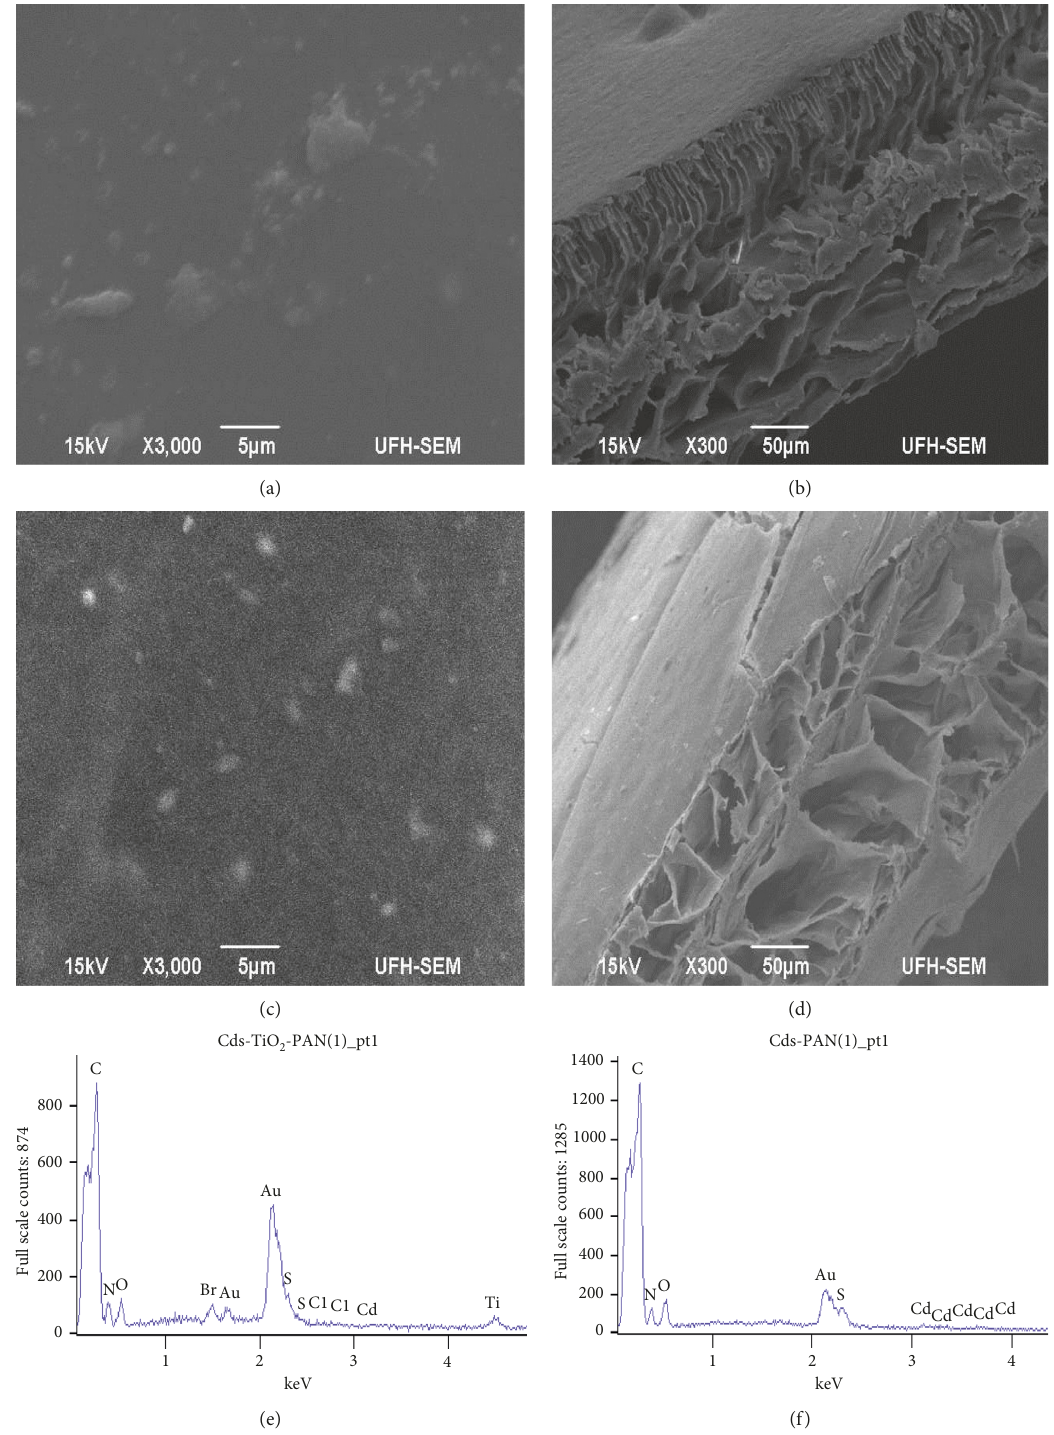
Figure 5: SEM images and cross-sectional view of (a, b) CdS/PAN membranes and (c, d) CdS/TiO CdS/TiO 2 -PAN and (f) CdS/PAN